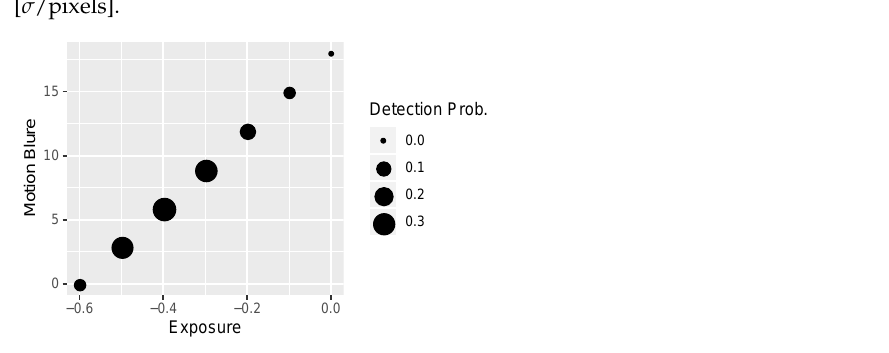
Figure 13. Face recognition detection [probability] for underexposure [eq units] and motion blur [ σ